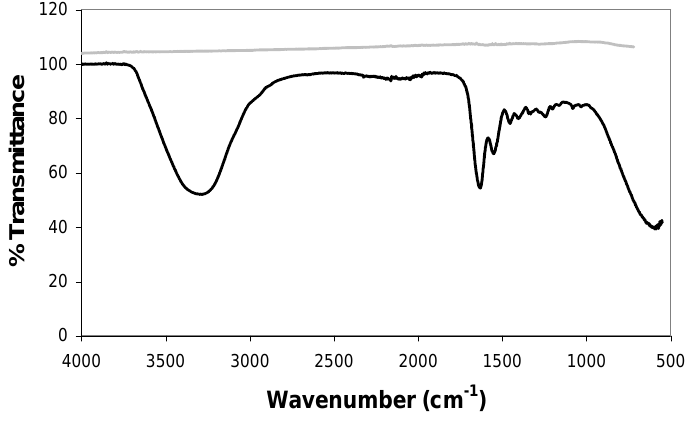
Figure 9. ATR-IR spectra of cp Ti (grey) and gelatin-coated Ti